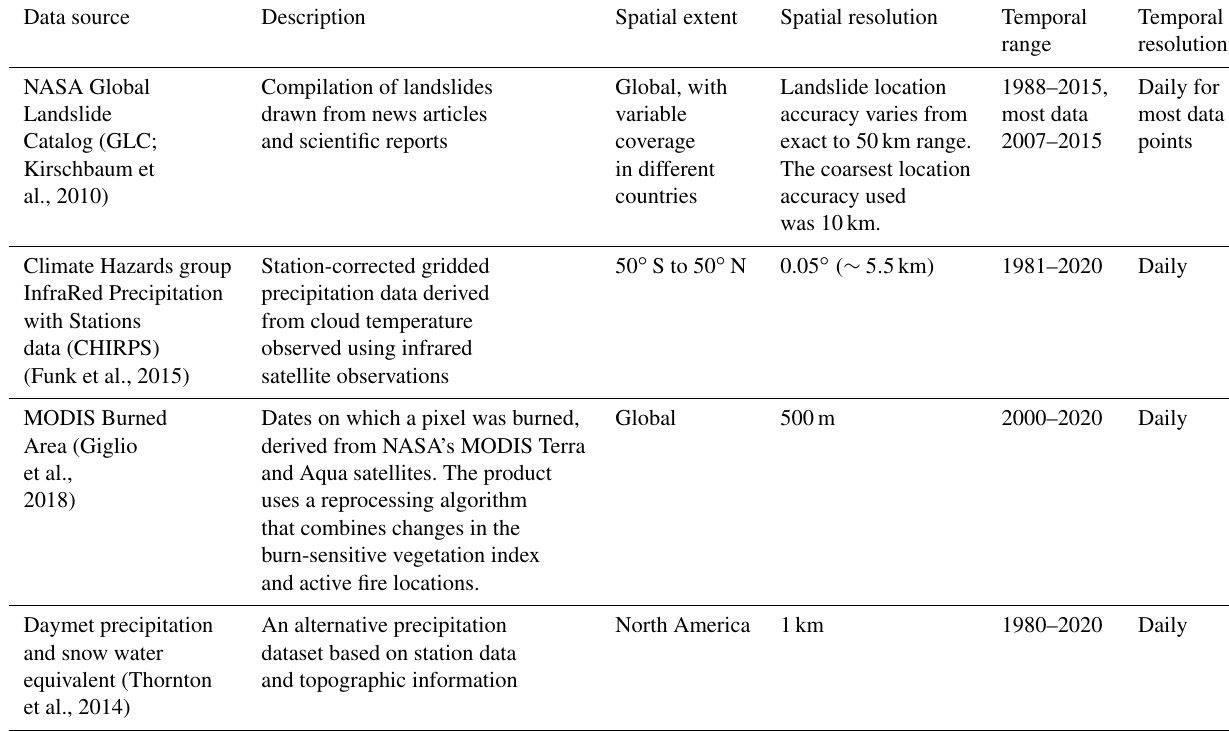
Table 1. Description of datasets used in the